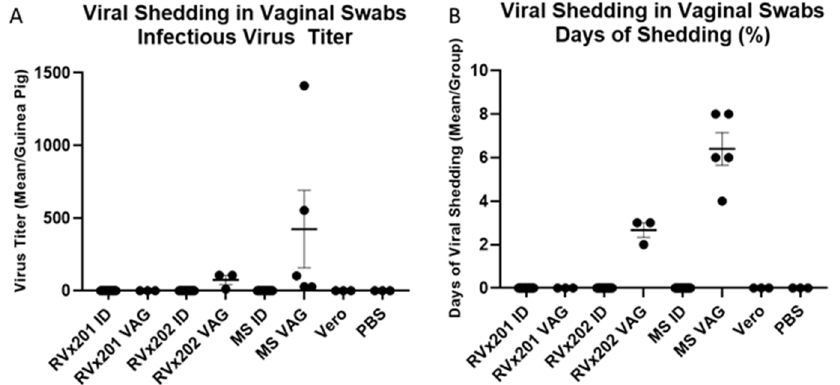
Figure 3. Guinea pigs were swabbed vaginally daily for the assessment of viral shedding. ( A ) Viral titers in vaginal secretions were determined via plaque assay. Guinea pigs vaginally infected with WT HSV-2 MS and RVx202 shed infectious virus in vaginal secretions. ( B ) The percentage of days that virus was shed in vaginal secretions was also determined. Guinea pigs vaginally infected with WT HSV-2 MS and RVx202 shed infectious virus in vaginal secretions. Guinea pigs infected ID with RVx201, RVx202, or MS shed significantly less infectious virus ( p < 0.0001) for significantly fewer days ( p < 0.0001) compared to MS VAG infected animals. Data are presented as mean ± SEM. P values were determined by ANOVA and post hoc Tukey’s test.